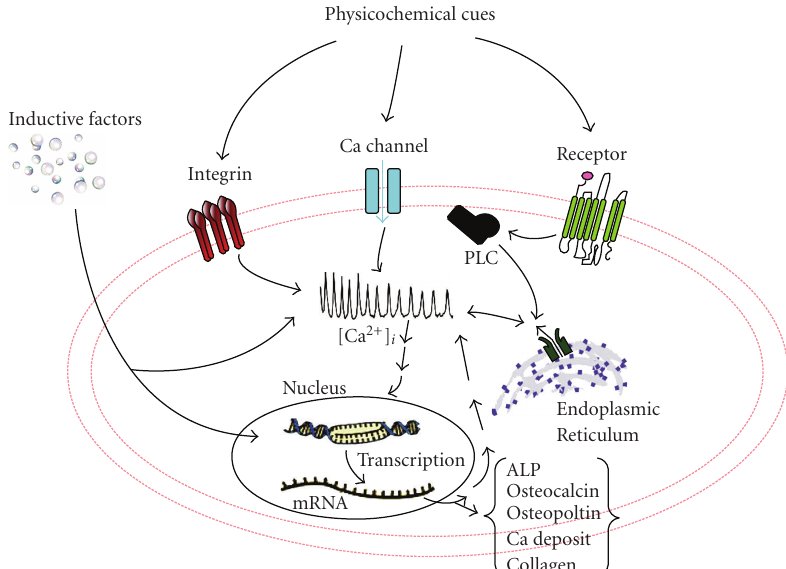
Figure 1: A schematic view of the potential e ff ect of physicochemical cues for osteodi ff erentiation. The inductive factors can di ff use across the cell membrane and produce immediate e ff ects, while physical cues can couple to the cell surface molecules. We envision that the mechanical or electrical cues can modulate the Ca 2+ dynamics by coupling to (1) ion channels, (2) G-protein coupled receptor-activated molecules (e.g., PLC), (3) integrin-mediated focal adhesion, and (4) ATP release [21,